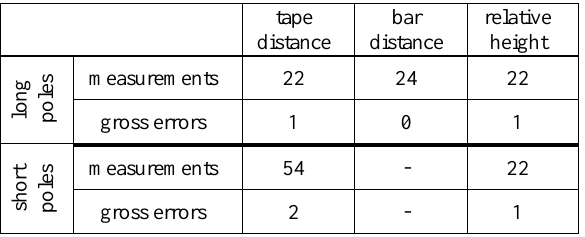
Tab.1: Measurements available for both, long and short pole, configurations. Note that the relative height measurements were the same in both